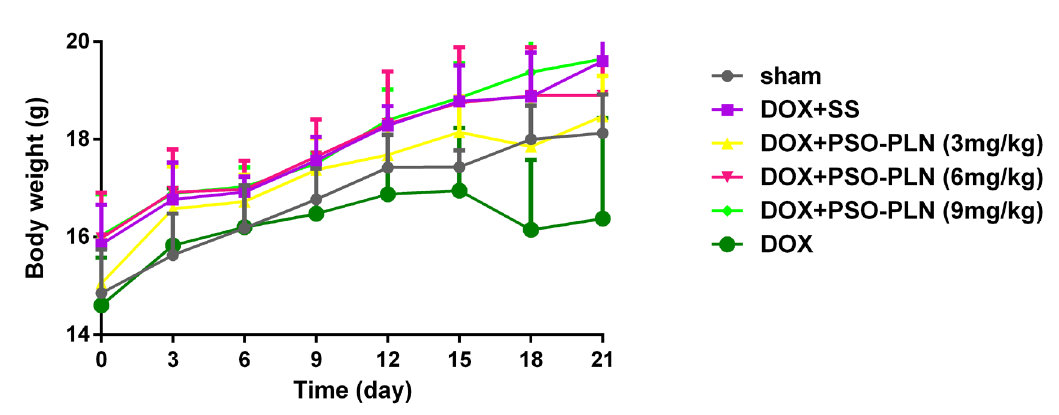
FIGURE 1 - Change in the body weight over 21 days in